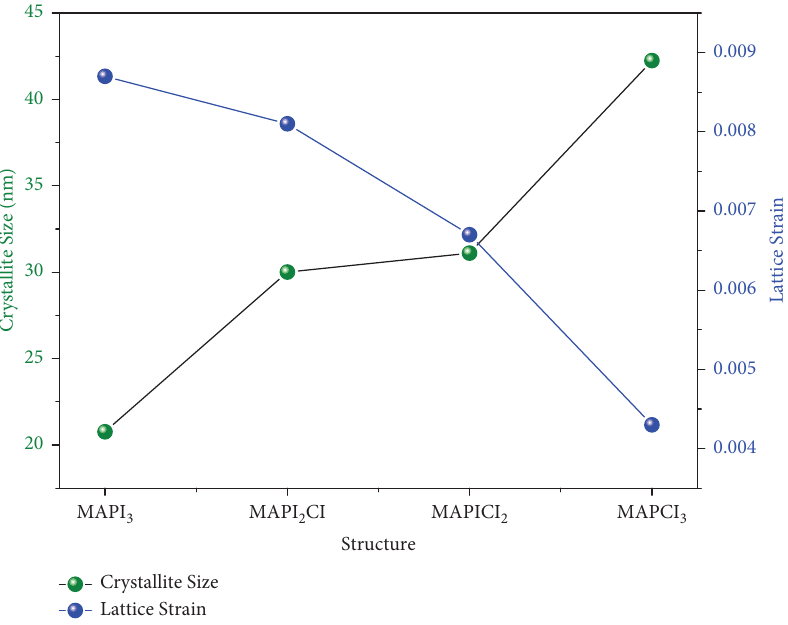
Figure 4: Crystallite size and lattice strain of the synthesized crystals.